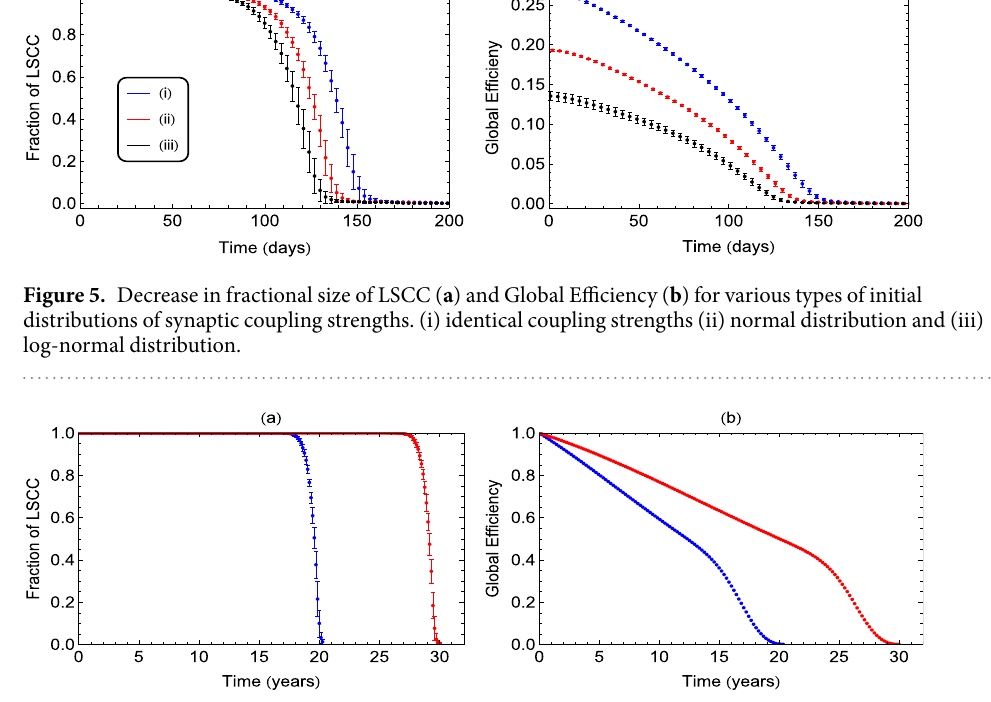
Figure 6. Decrease in the fractional size of the LSCC ( a ) and Global Efficiency ( b ) with synapse losses in the constructed human brain network. Decay of links is studied for values of τ = 40 (blue) and τ = 80 (Red). The values of GE are normalized by the initial value to emphasize the relative decrease due to synaptic